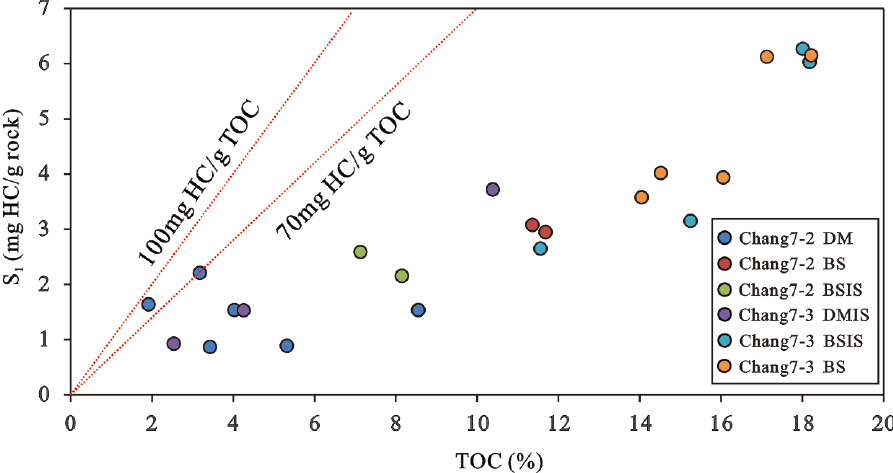
Figure 14. The cross-plot of S 1 versus TOC content for source rocks from well CYX.